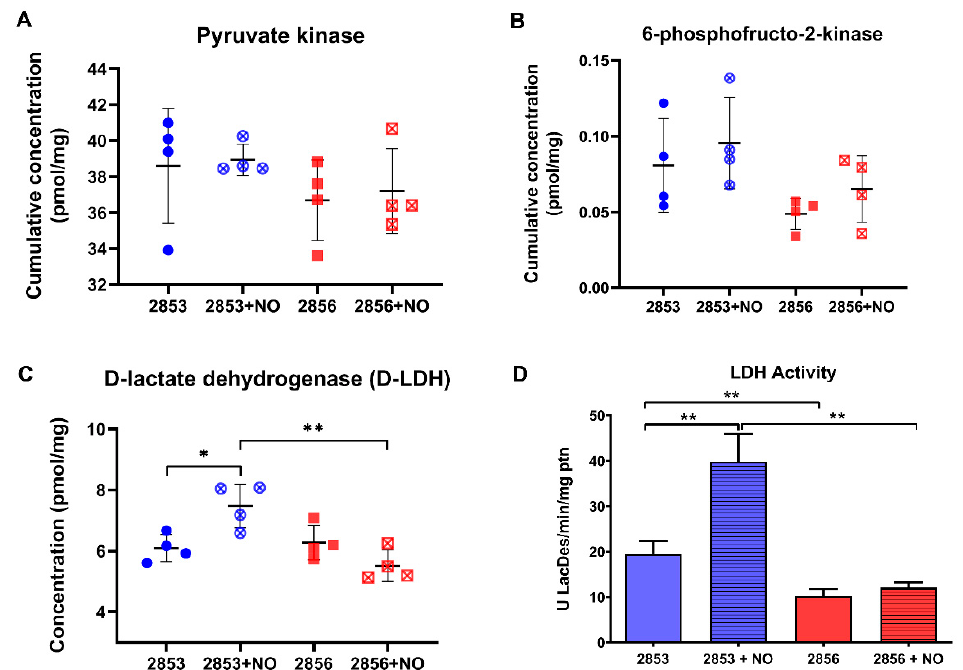
Figure 7. Nitrosative challenge increases D-lactate dehydrogenase (D-LDH) abundance in NO-resistant L. braziliensis strain. ( A ) Protein concentration of pyruvate kinase; ( B ) cumulative concentration of 6-phosphofructo-2-kinase; ( C ) protein concentration of D-lactate dehydrogenase (D-LDH); and ( D ) LDH activity in parasite homogenates. Graphs represent mean ± SD of at least four independent experiments. Statistical differences by Student’s t test (* p < 0.05; ** p < 0.01). 2853: NO-resistant strain; 2853+NO: NO-resistant strain challenged with 1 / 5 IC 50 /4h NaNO 2 ; 2856: NO-susceptible strain; and 2856+NO: NO-susceptible strain challenged with 1 / 5 IC 50 /4h NaNO 2 . 3.8. Nitrosative Challenge Impairs Mitochondrial O 2 Consumption by L. braziliensis Strains